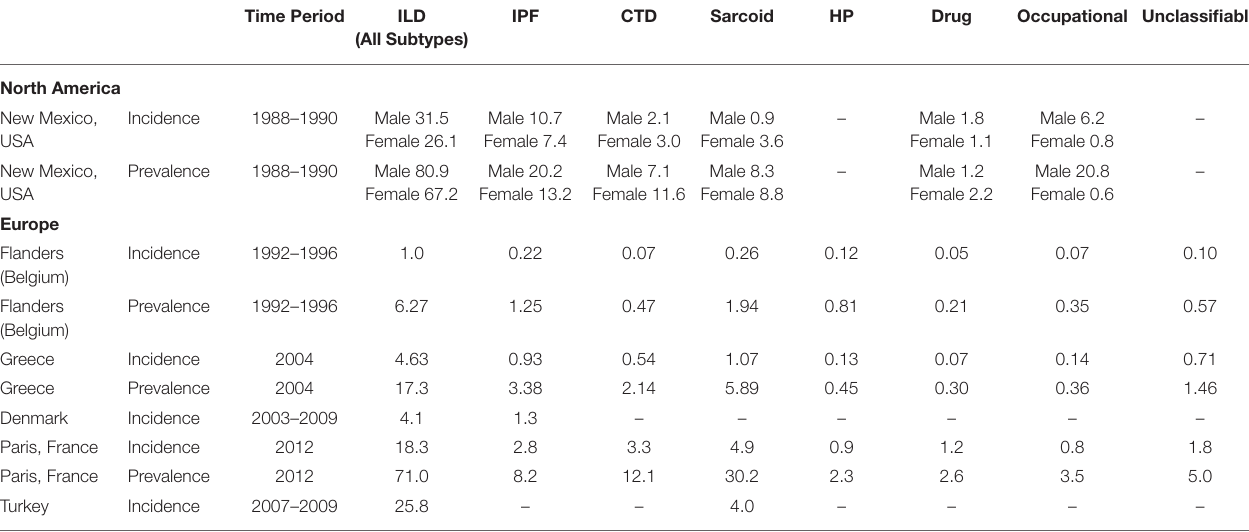
TABLE 1 | Incidence and prevalence of interstitial lung disease